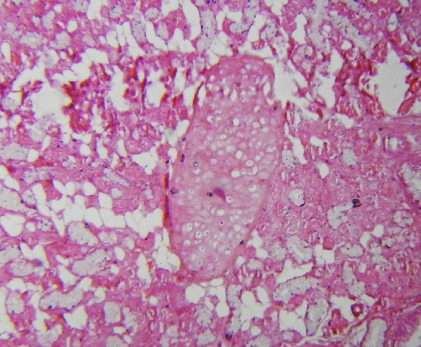
Figure 5: Section from tumor showing a cartilage island within salivary tissue, H & E 10x